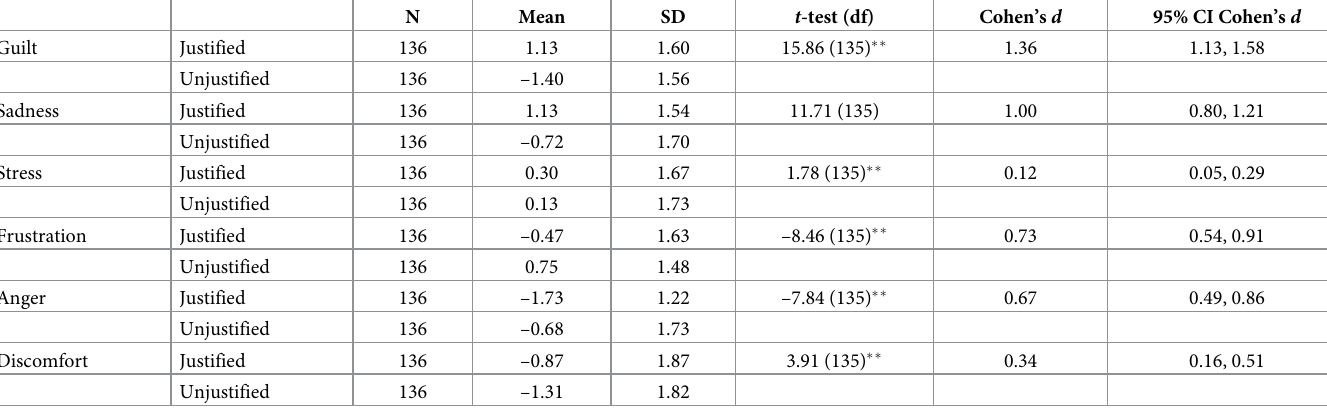
Table 4. T-tests for children’s justified and unjustified negative emotions in relation to caregivers’ emotions.